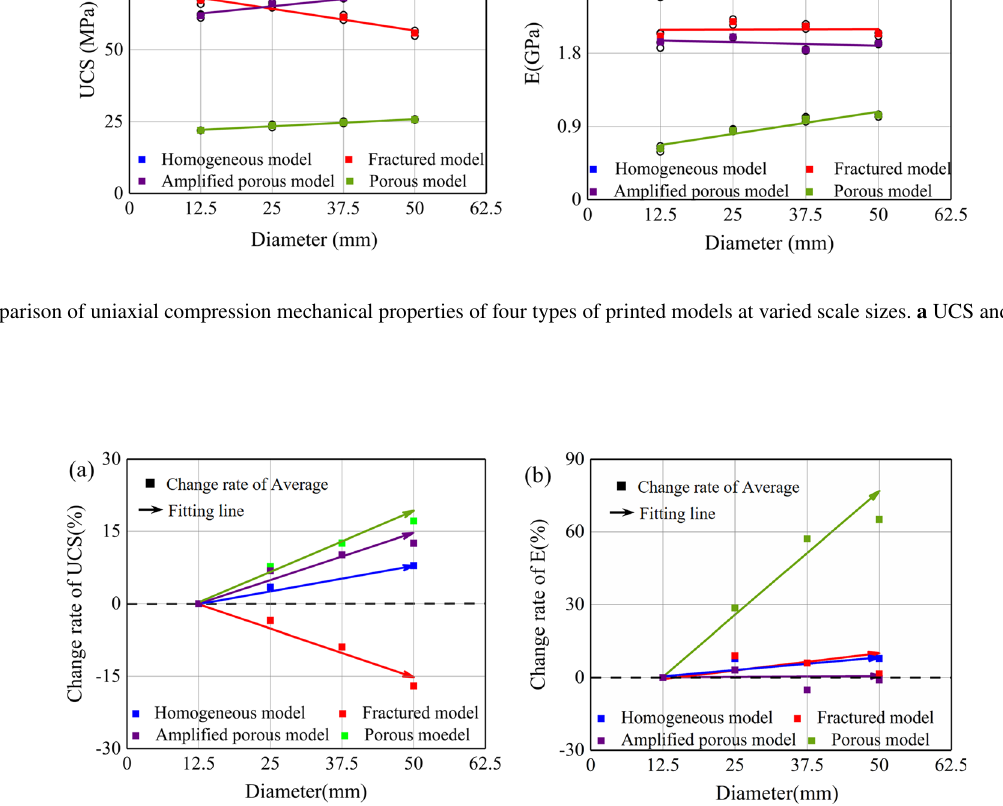
Fig. 9 Experimental results of the model with a diameter of 12.5 mm were used as a reference to quantify the size effect of the model with